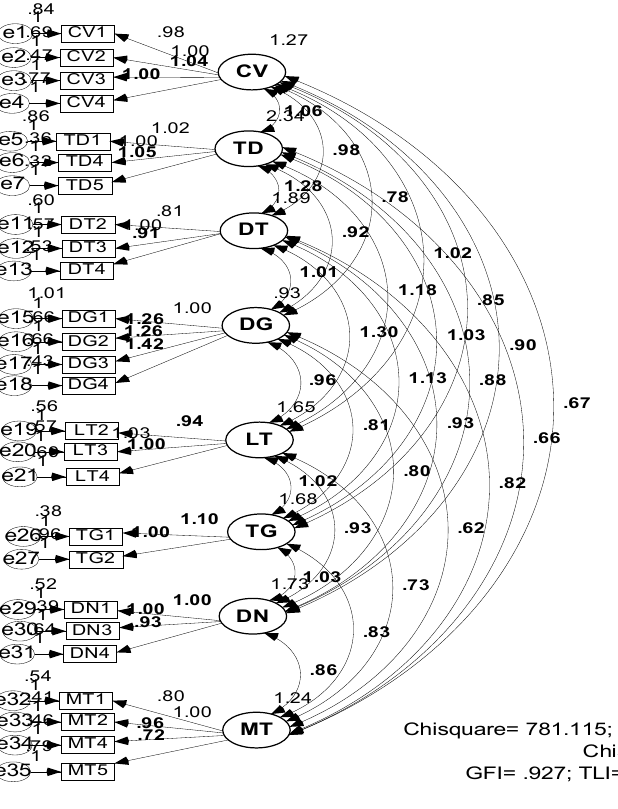
Fig. 3. CFA results on scales measuring HRMP Source: Author’s estimation from survey